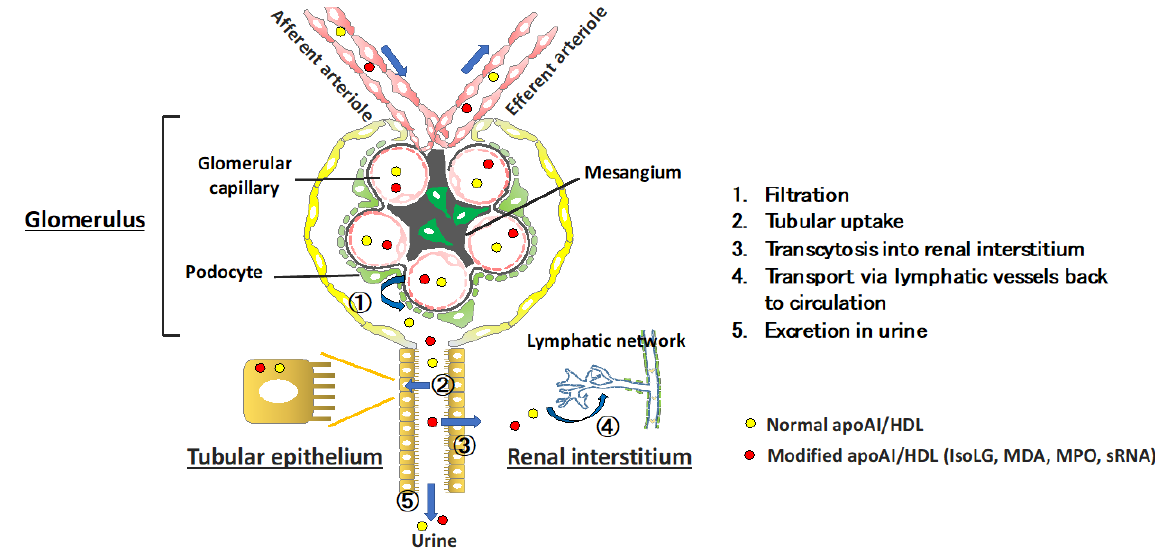
Figure 1. Kidney handling of normal and modified apoAI/HDL by the glomerulus, tubule epithelium, and renal interstitium involves (1) filtration (2) tubular uptake (3) transcytosis (4) transport by lymphatic vascular network in interstitium and (5) urinary excretion.